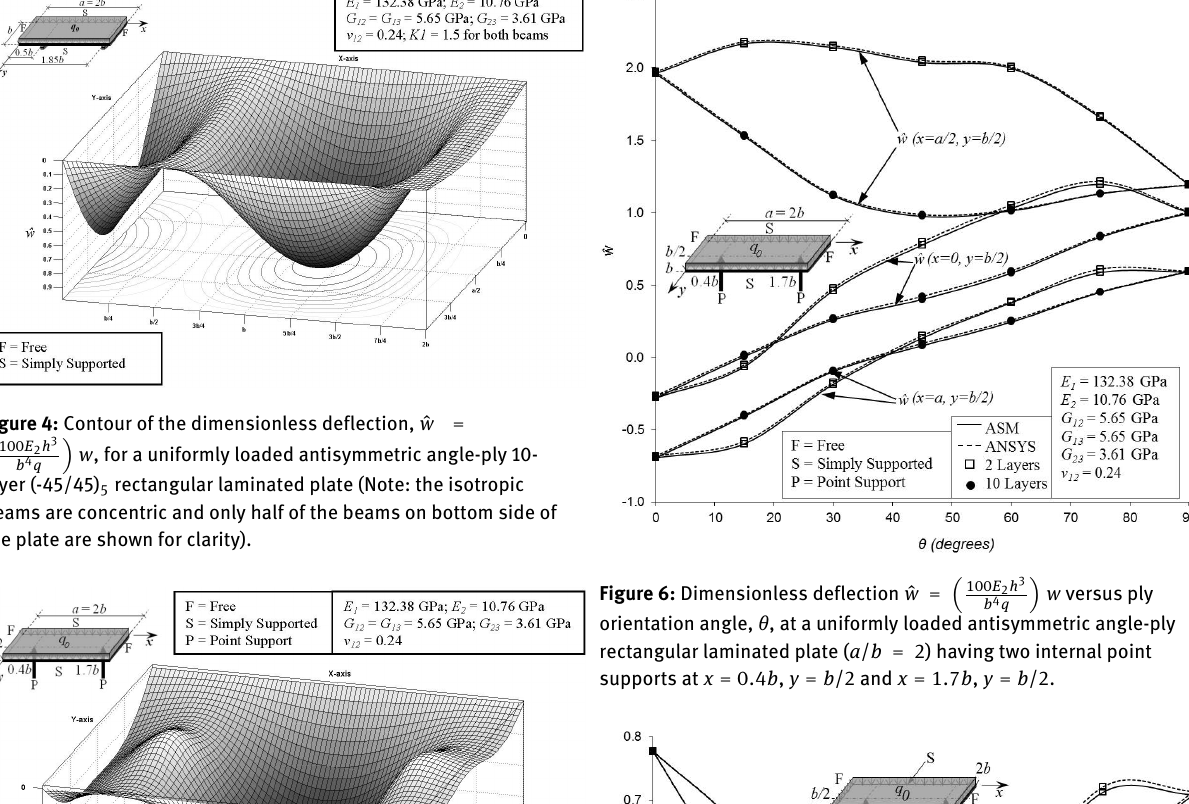
Figure 5: Contour of the dimensionless deflection, ^ w = (︁ 100 E )︁ 2 h 3 w , for a uniformly loaded antisymmetric angle-ply 2- b 4 q layer (-45/45) rectangular laminated plate ( a / b = 2) having simply supported on y = 0 and y = b , two point supports at x = 0.4 b ,